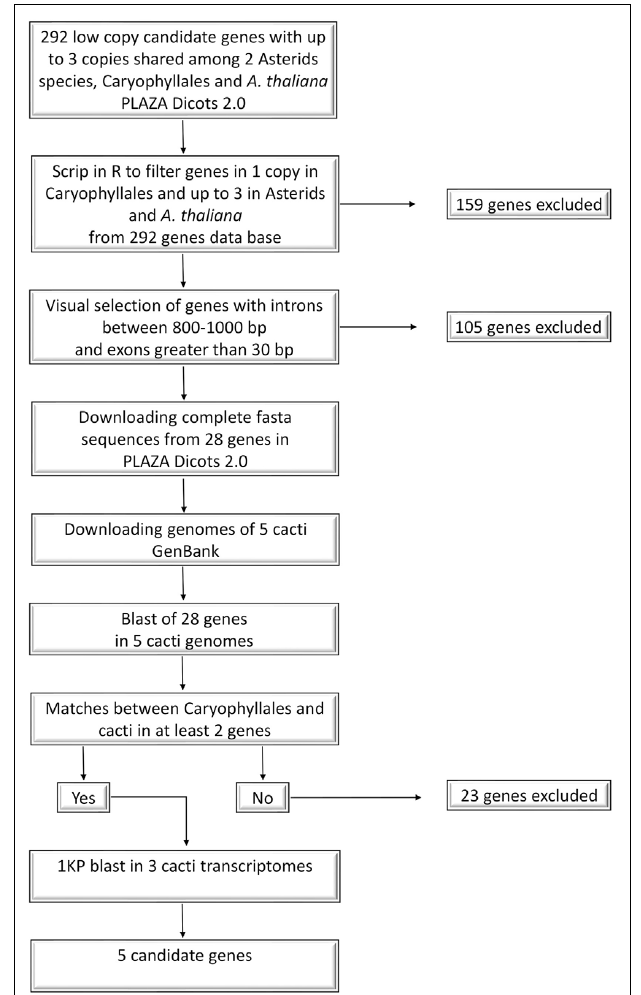
FIGURE 3 | Transcriptome and genome mining